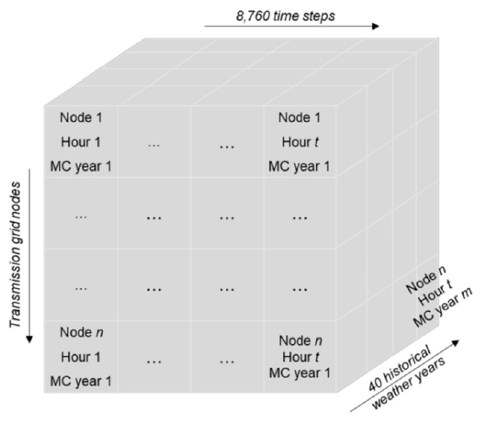
Figure 3. Schematic view of the results of the Monte Carlo scenario generation [15].